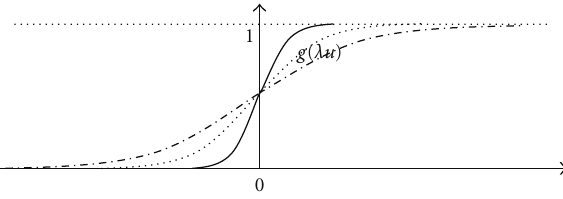
Figure 5: Curve of a sigmoid function.